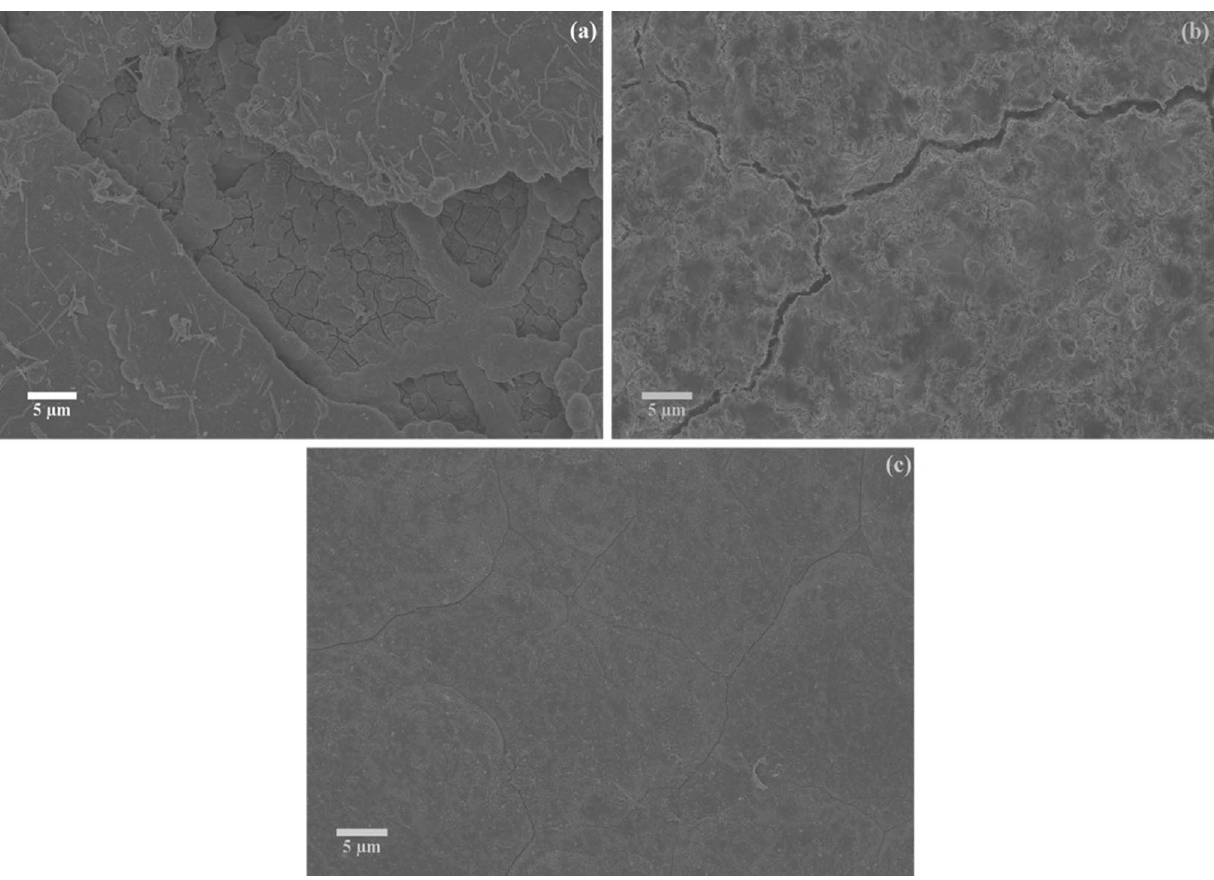
Fig. 3 FESEM image of pulse-electrodeposited Ni–Cr–P alloy at a pH 2.0 (± 0.15), b pH 2.5 (± 0.15), and c pH 3.0 (± 0.15); having constant temperature (25